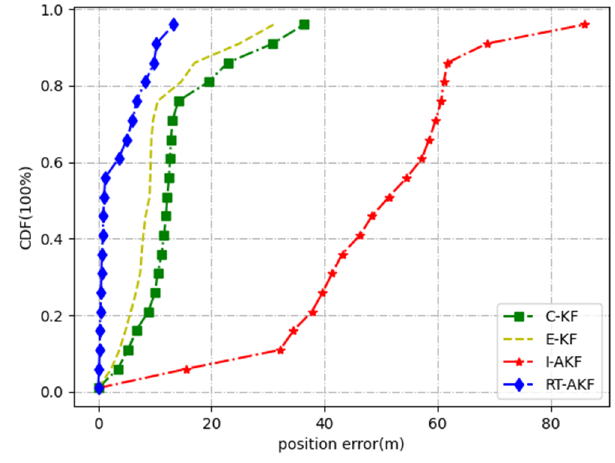
Figure 9. Accuracy comparison by different methods in segment #2.